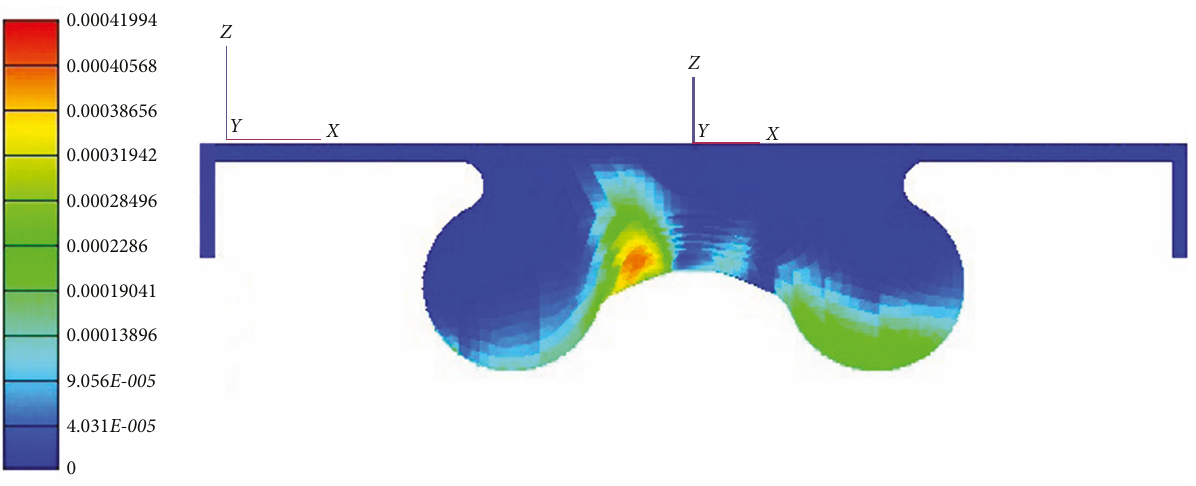
Figure 12: The distribution of soot under 730 ° CA of program 2. Table 2: AVL DITEST Gas 1000 technical